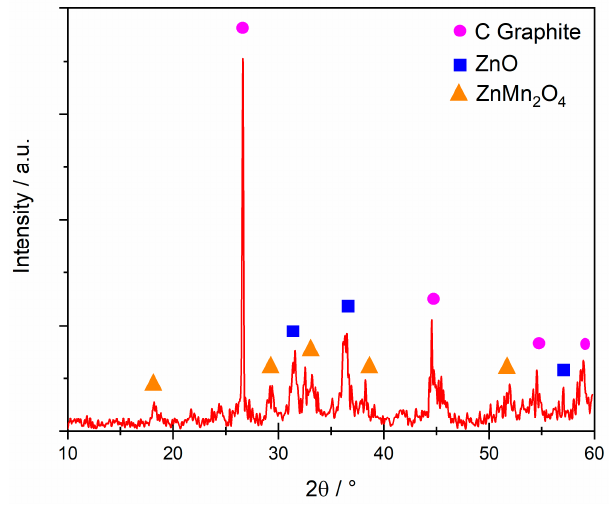
Figure 5. XRD pattern of solid residue after leaching: temperature 150 °C and solid/NADES ratio of 3 g dm − 3 .